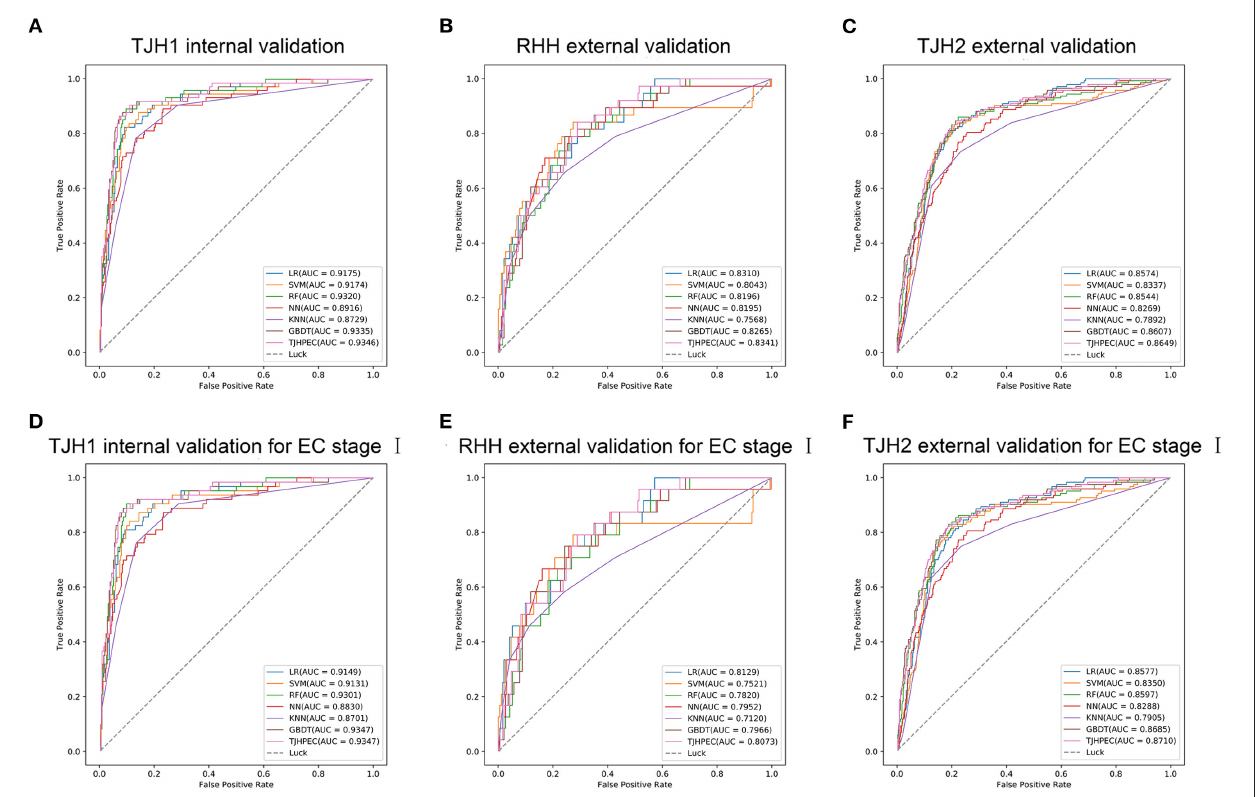
FIGURE 3 | Evaluation of the efficiency of the diagnostic prediction of models (LR, SVM, RF, NN, KNN, GBDT, and TJHPEC) using ROC curves for the total EC cohorts ( A , TJH1 internal validation set; B , RHH external validation set; C , TJH2 external validation set) and stage I EC cohorts ( D , TJH1 internal validation set; E , RHH external validation set; F , TJH2 external validation